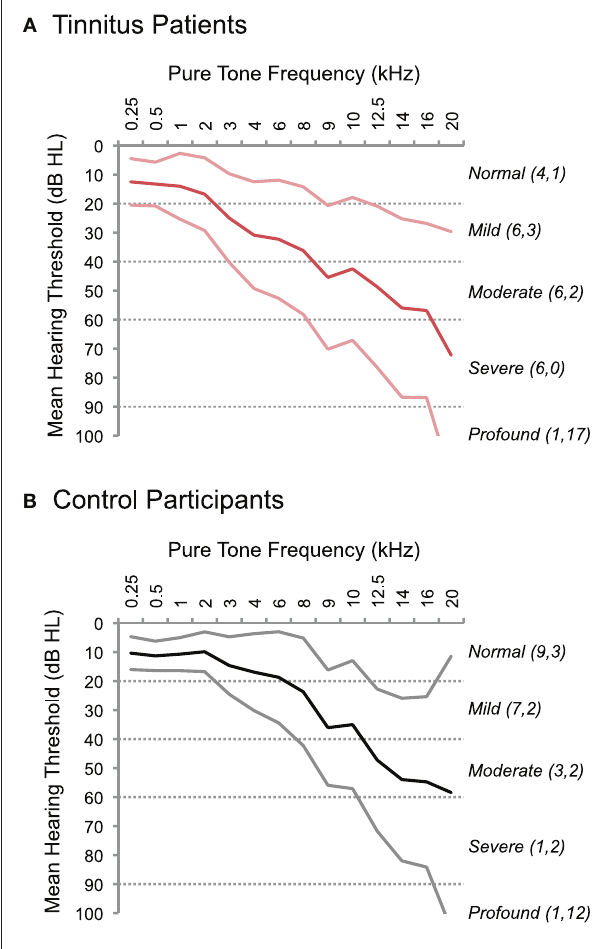
FIGURE 1 | Hearing thresholds in tinnitus patients and controls. The results of pure-tone audiometry are plotted for tinnitus patients (A) and control participants (B) . Thresholds in dB Hearing Level (HL) are displayed on the y-axis, and test frequencies are plotted on the x-axis, including standard audiogram frequencies up to 8kHz and extended test frequencies > 8kHz. Thick lines indicate the mean threshold; thinner lines indicate standard error above and below the mean. Dotted lines delineate ranges of normal ( ≤ 20dB HL), mild (20–40dB HL), moderate (40–60dB HL), severe (60–90dB HL), and profound ( > 90dB HL) hearing loss. The number of participants with maximum hearing loss in at least one frequency is indicated for each category in parentheses on the right, separately for standard (first number) and extended (second number) ranges of test